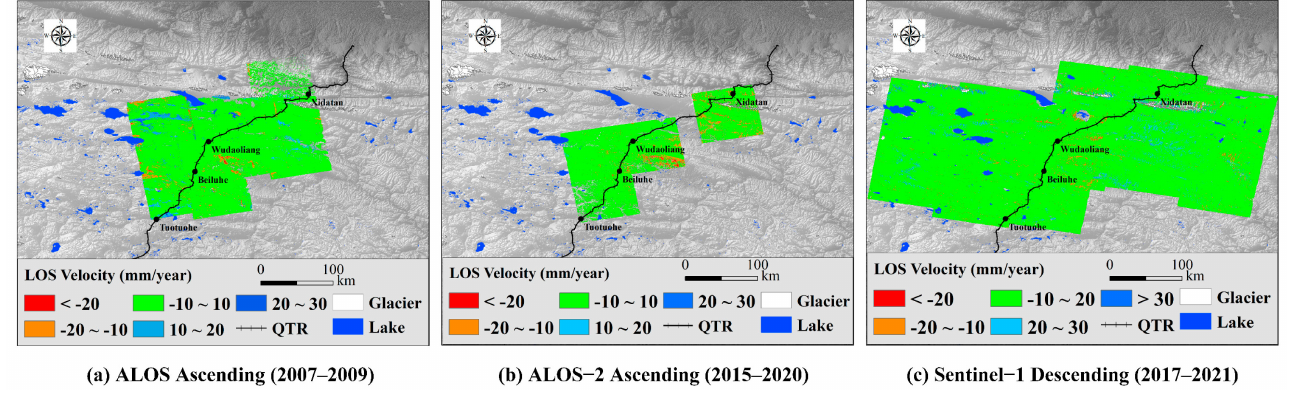
Figure 3. Long-term deformation results of the study area. Background is the DEM. ( a ) ALOS result (2007–2009). ( b ) ALOS-2 result (2015–2020). ( c ) Sentinel-1 result (2017–2021). In Figure 3, the red color indicates the subsidence in the LOS direction, and the blue color is the uplift toward the satellite. There are a large number of lakes (deep blue color) in the western part of the study area. From the three different deformation maps obtained by using three different SAR sensors, we find that the long-term deformation velocity in the northern QTP ranges from − 20 to +20 mm/year (ALOS, 2007–2009), − 30 to 15 mm/year (ALOS-2, 2015–2020), and − 25 to 30 mm/year (Sentinel-1, 2017–2021). Further study shows that the expansion areas of permafrost subsidence are concentrated on braided stream plains and thermokarst lakes. In these areas, due to glacial erosion, surface runoff and river alluvium, the contents of water and ground ice are sufficient, which could accelerate permafrost